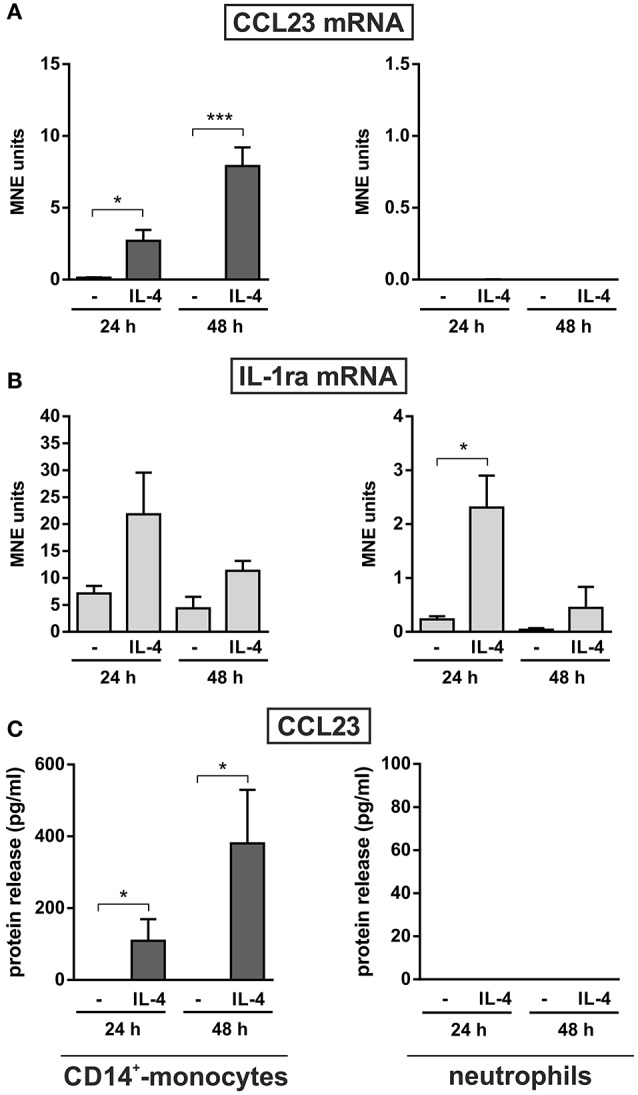
Effect of IL-4 on the production of CCL23 by monocytes and neutrophils. CD14+-monocytes and neutrophils were cultured at 5 × 106 cells/ml with or without 20 ng/ml IL-4 for 24 and 48 h to evaluate their CCL23 (A) and IL-1ra (B) mRNA expression by RT-qPCR, as well as their CCL23 release (C) by ELISA (n = 4). Gene expression data are depicted as MNE units after GAPDH mRNA normalization (mean ± SEM). Asterisks stand for significant increases: *P < 0.05, ***P < 0.001 by two-way ANOVA followed by Bonferroni's post-test.